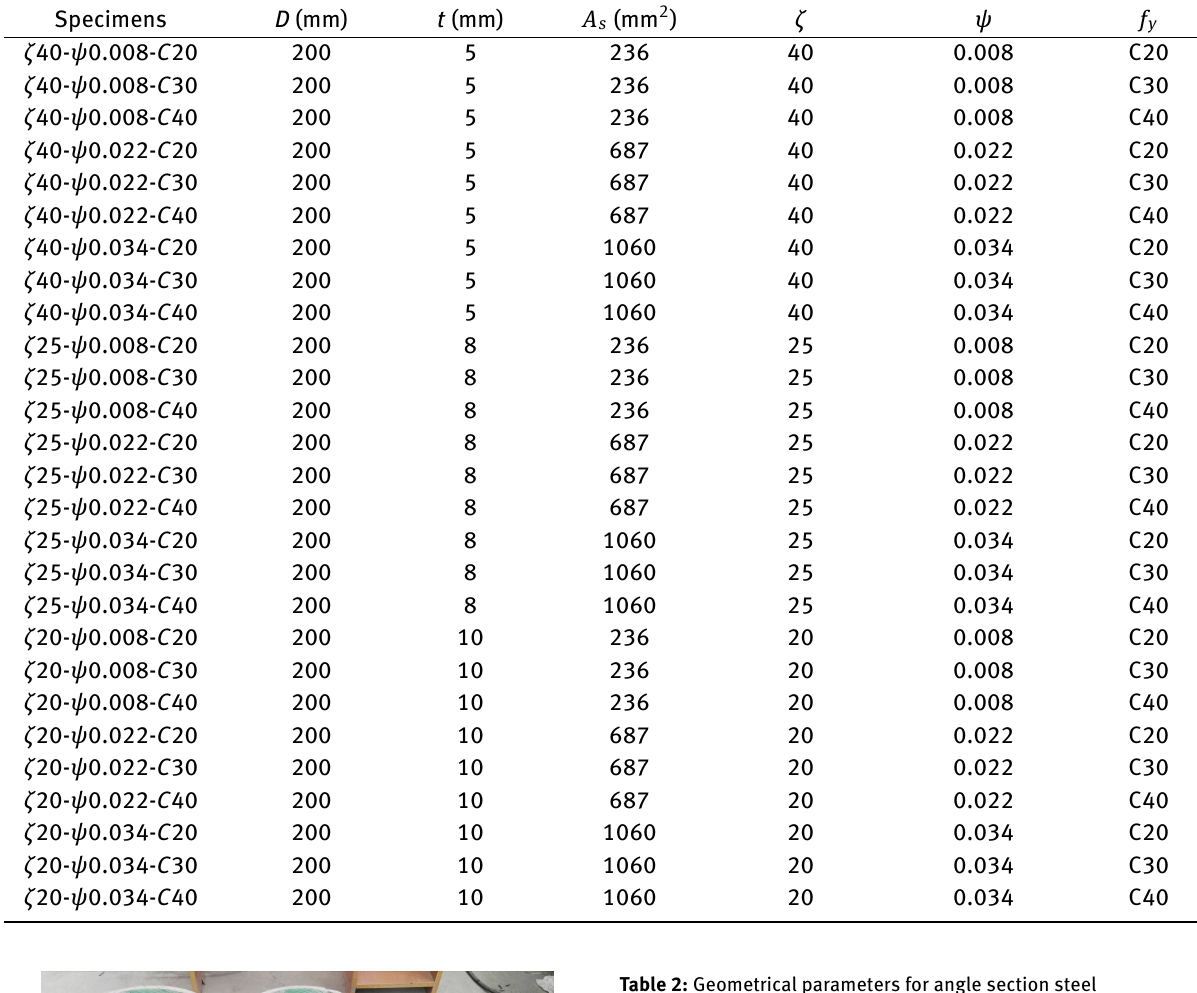
Table 1: Details of specimens in test